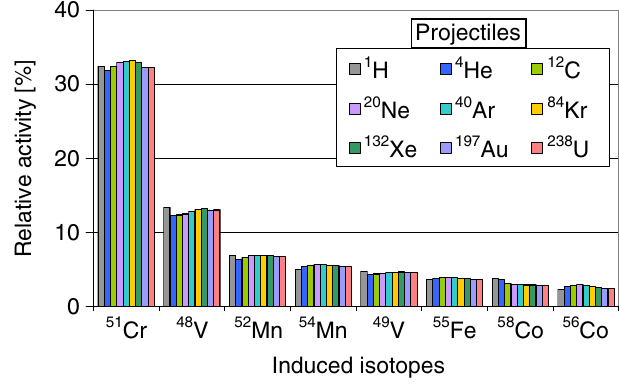
FIG. 3. (Color) Relative activities of the isotopes induced by 1 GeV = u projectiles from proton up to uranium in the stainless steel beam pipe 1 day after the end of irradiation. The relative standard uncertainty of the calculated activities ranged from 0.19% (high-activity isotopes) to 1.17% (low-activity isotopes).